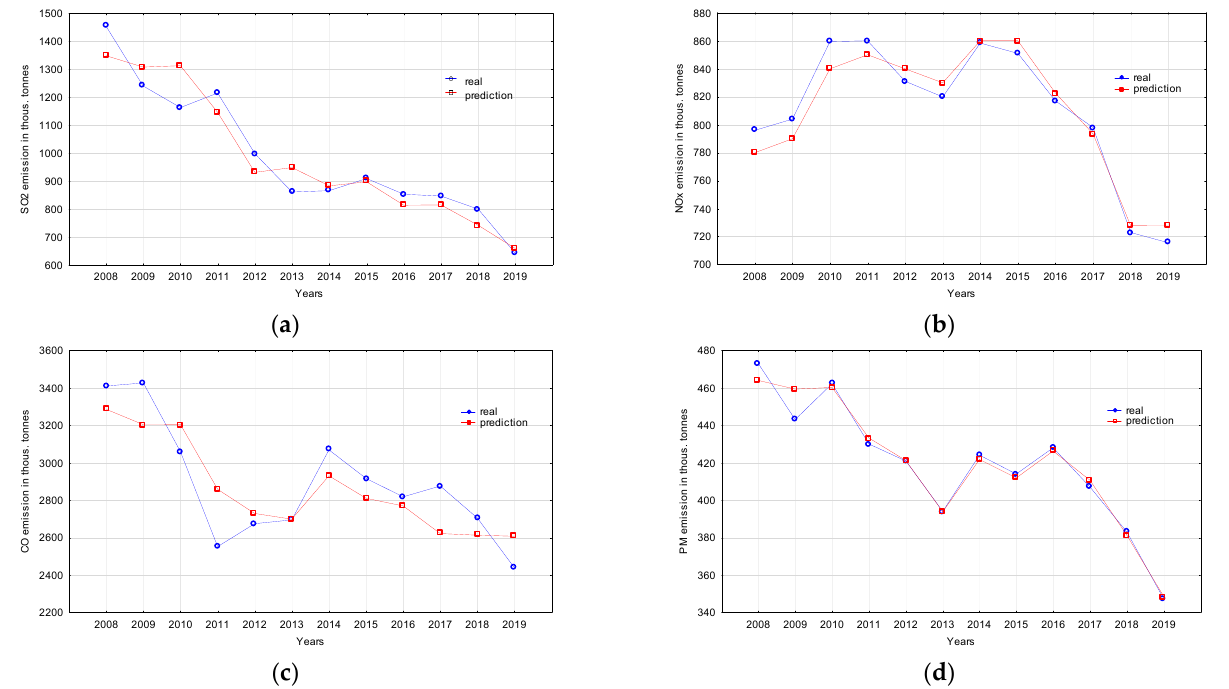
Figure 6. Results of SA for ( a ) SO 2 ; ( b ) NO x ; ( c ) CO; ( d ) PM. To verify the effectiveness of the models created, the actual data were compared with the data obtained through modelling (Figure 7).